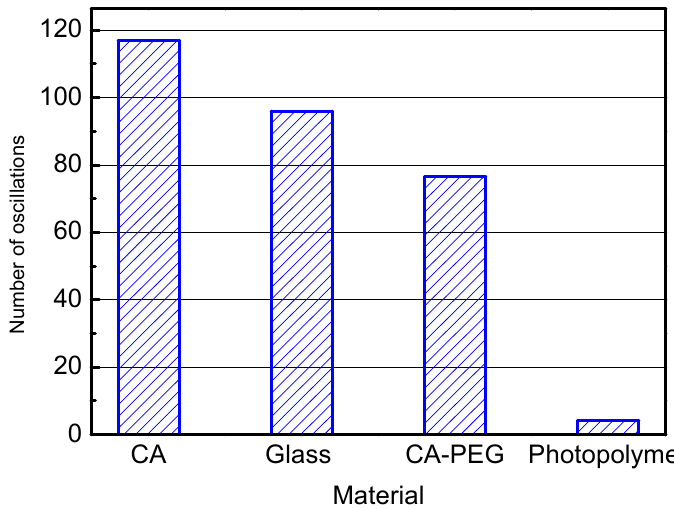
Figure 13. Pendulum hardness studies of CA, glass substrate, CA–PEG and photopolymer.